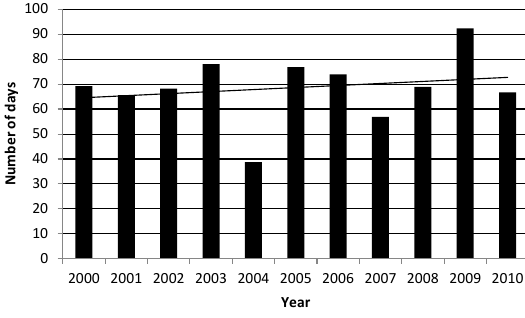
Figure 1. Number of days with temperatures above 30 ◦ C (90th per- centile) on Aguascalientes, Mexico.